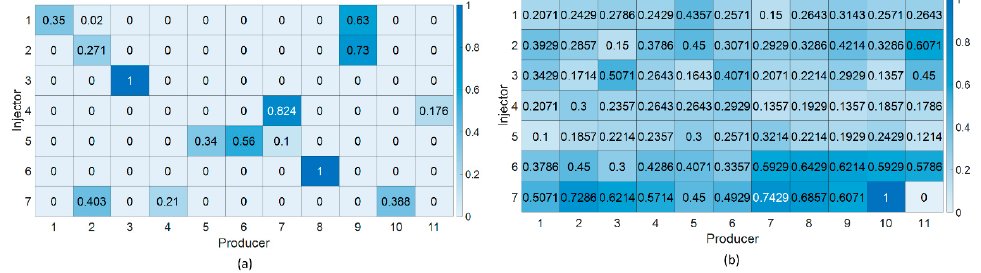
Figure 11. The disequilibrium factors of Olympus model. ( a ): The results obtained via IRNN; ( b ) The results obtained via MLP.